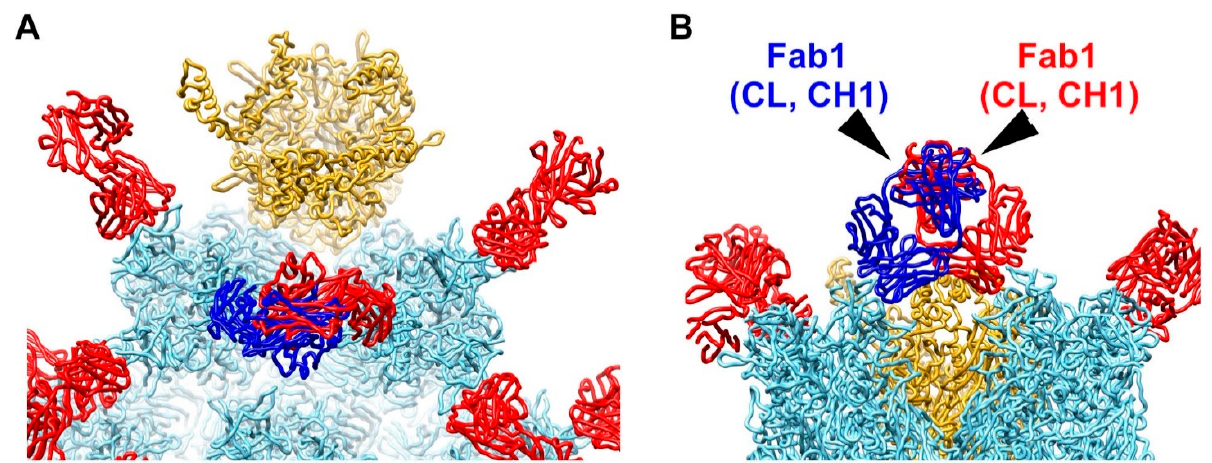
Figure 2. Steric clashes are modeled between two 9C12 Fab fragments bound to neighboring peripentonal hexons. ( A ) Enlarged view of vertex region with two hexon trimers and one penton base with selected 9C12 Fab fragments as in Figure 1D. A severe steric clash is modeled between Fab fragments (blue and red) bound to neighboring peripentonal hexons. ( B ) Perpendicular view of panel A. The clashing domains (CL, CH 1 ) of each Fab are indicated.